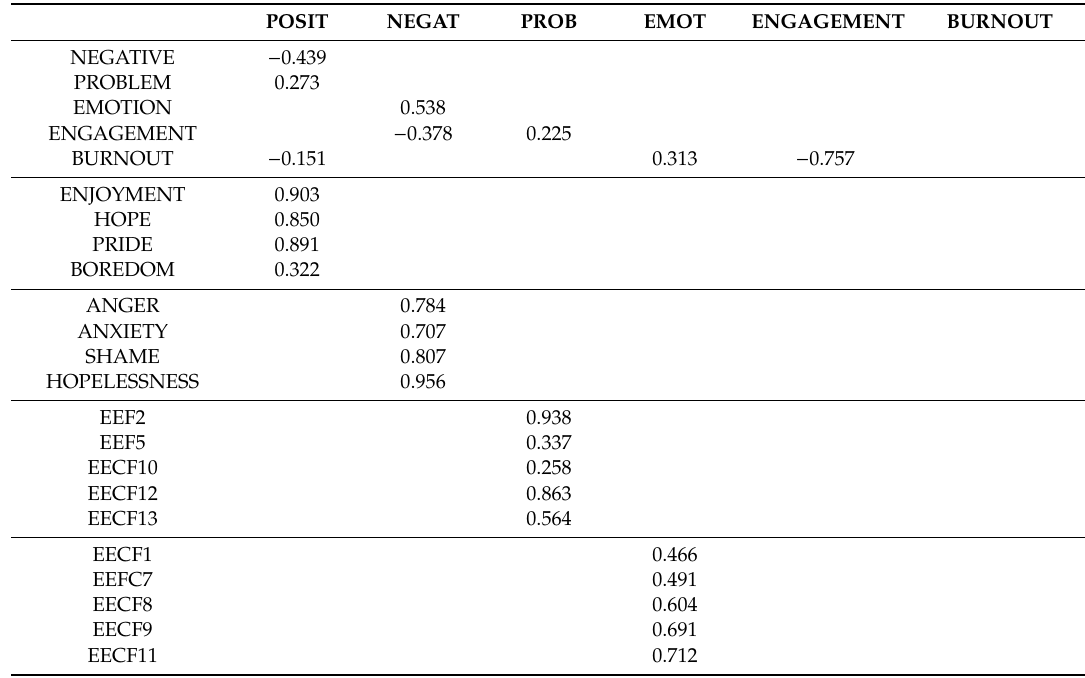
Table 10. Standardized Direct E ff ects (Default model): Test